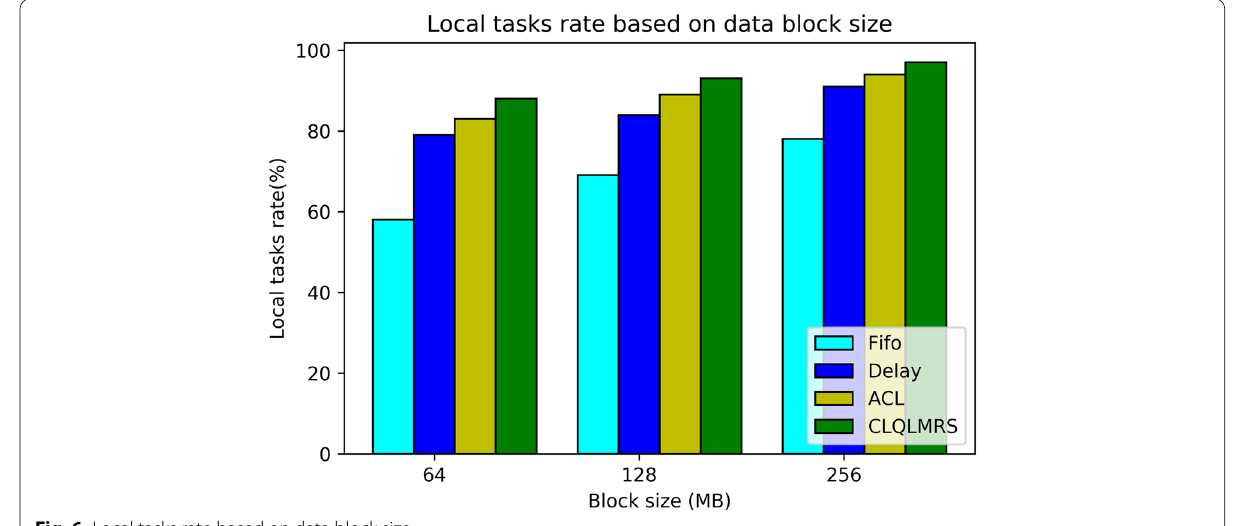
Fig. 6 Local tasks rate based on data block size